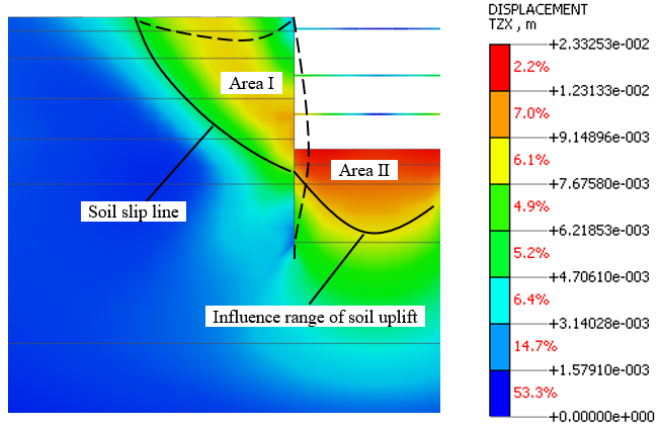
Figure 6. Partition diagram of the displacement and deformation characteristics of the foundation pit excavation.